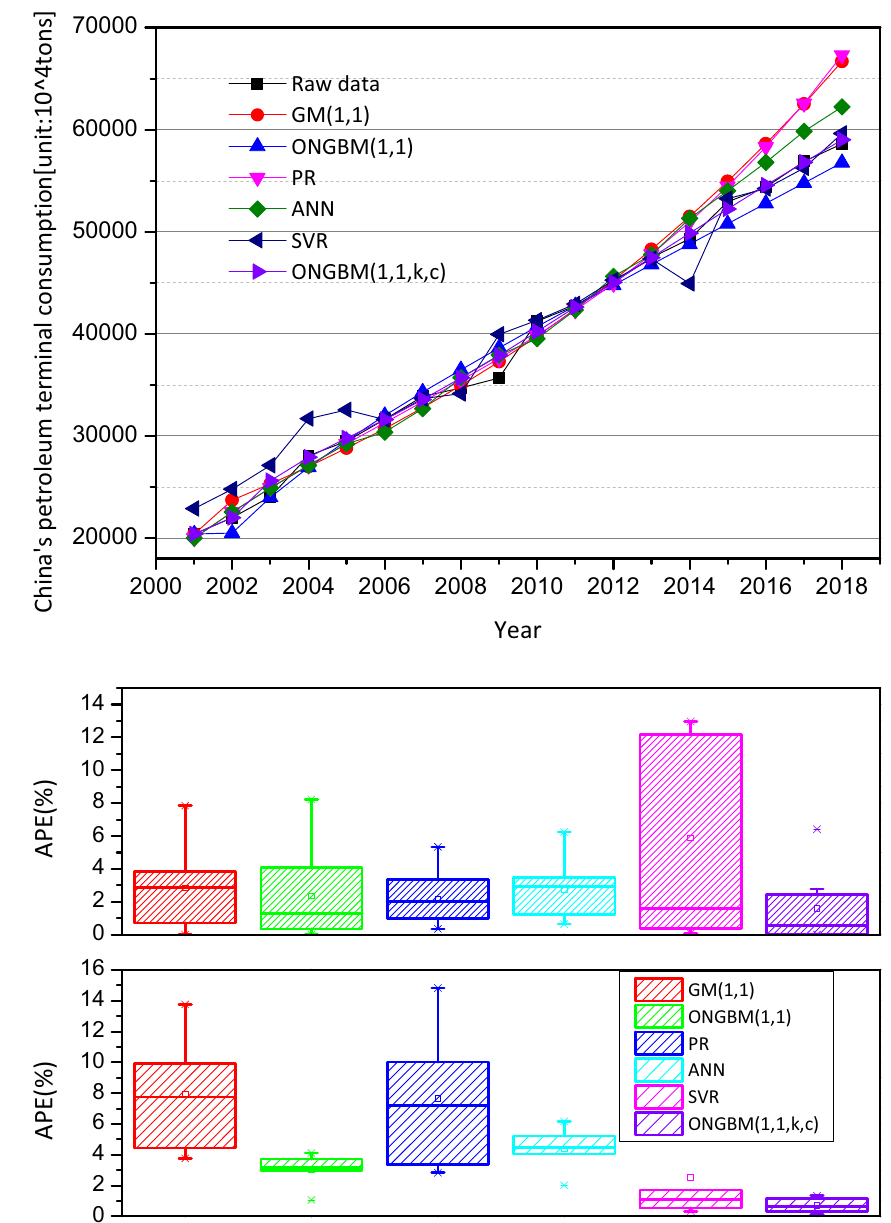
Fig. 6 Comparison of forecasted and actual values in China’s petroleum terminal consumption